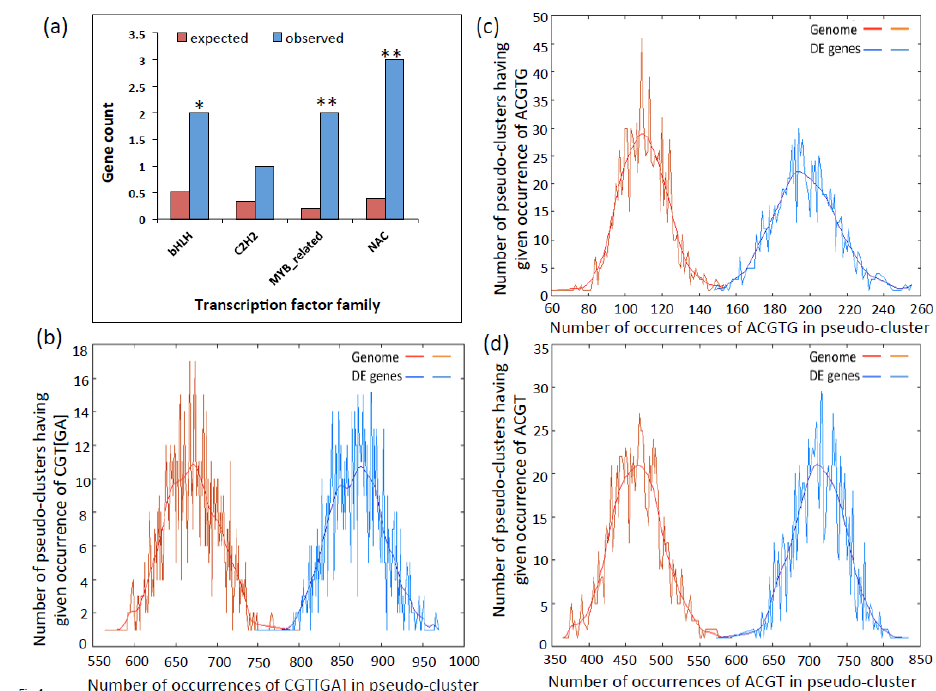
Figure 4. Enrichment of transcription factor families and VOZ binding sites in the promoters of DE genes. ( a ) DE genes are enriched for specific TF families. Observed: Number of genes associated with particular TF family in DE genes. Expected: Number of genes expected in each individual TF family in the genome. Asterisks on the bar represent significant overrepresentation of TFs with a (* p ≤ 0.05) and (** p ≤ 0.0001), respectively. ( b – d ) POBO analysis of NAC consensus sequence ( CGT[GA] ), G-box core sequence ( ACGTG ) and LS-7 cis -element ( ACGT ), respectively, in the − 1000 bp upstream of TSS. One thousand pseudoclusters were generated from top 112 DE genes and genome background. The jagged lines show the motif frequencies from which the best-fit curve is derived. CGT [ GA ], ACGTG and ACGT elements are significantly overrepresented (two-tailed p < 0.0001) in the upstream sequences of DE